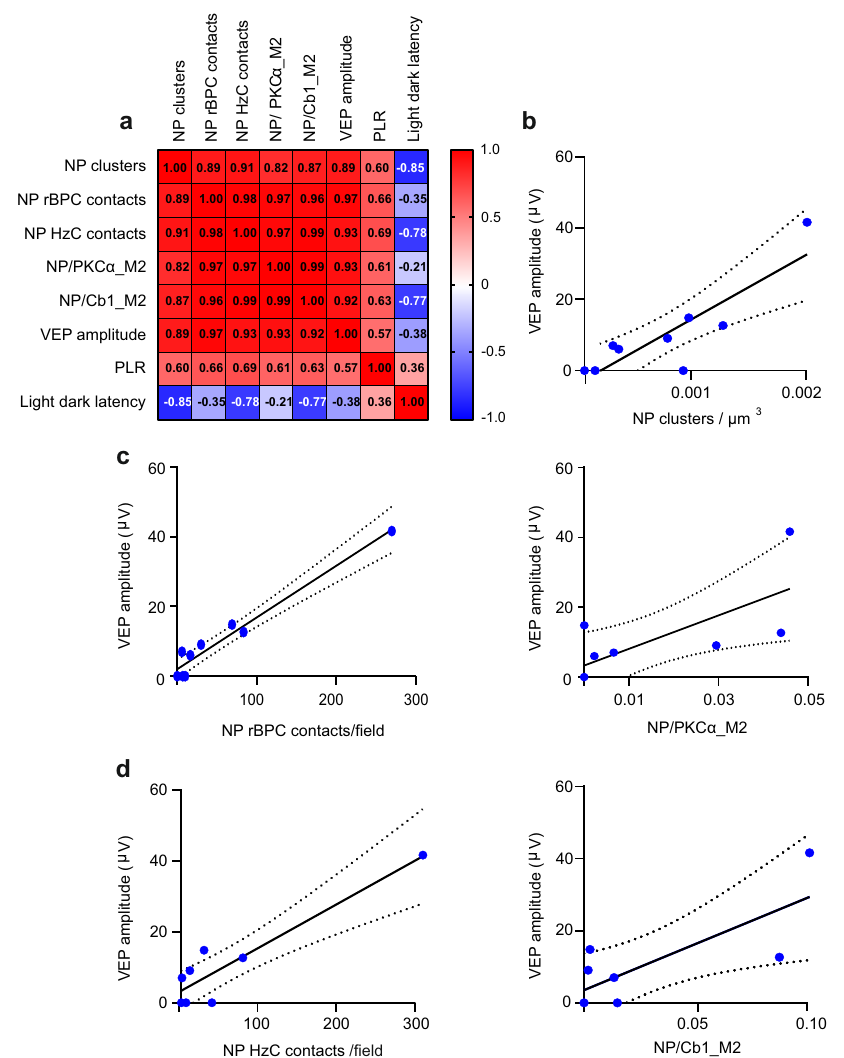
Fig. 9 The extent of visual rescue is positively correlated with the P3HT-NP cluster density and contacts with second-order retinal neurons. a Correlation map of P3HT-NP morphological parameters in the retina and the resulting visual performances in P3HT-NP injected aged RCS rats. In the map, different variables are indicated in each row and each column, while squares represent their correlation. The Pearson ’ s correlation coef fi cient, indicated in each square, shows a strong correlation between each morphological parameter (P3HT-NP clusters, contacts with rBCPs and HzC, Manders M2 overlap coef fi cient for PKC α -positive rBPCs and Calbindin1-positive HzCs) and visual performances (VEP amplitude, PLR constriction, light – dark escape latency). Sample size: RCS + P3HT n = 6. b – d Linear regression analysis of the correlation between VEP amplitude and morphometric parameters describing the P3HT-NP distribution (NP cluster density, rBPC/HzC contacts per fi eld, Manders M2 coef fi cient for rBPC/HzC; see Fig. 3). The Pearson ’ s correlation coef fi cient showed signi fi cant correlations of VEP amplitude with all the morphometric parameters that have been considered. NP cluster density: p = 0.003, r = 0.7, n = 9 b ; NP-rBCP contacts/ fi eld: p < 0.001, r = 0.9, n = 9 and NP/PKC α _M2: p = 0.02, r = 0.72, n = 8 ( c ); NP-HzC contacts/